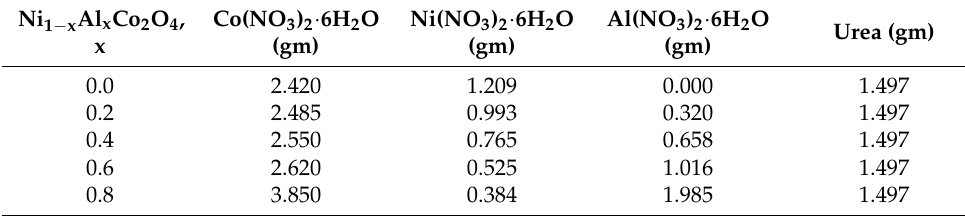
Table 1. Stoichiometry of chemicals used in the synthesis of Ni 1 − x Al x Co 2 O 4